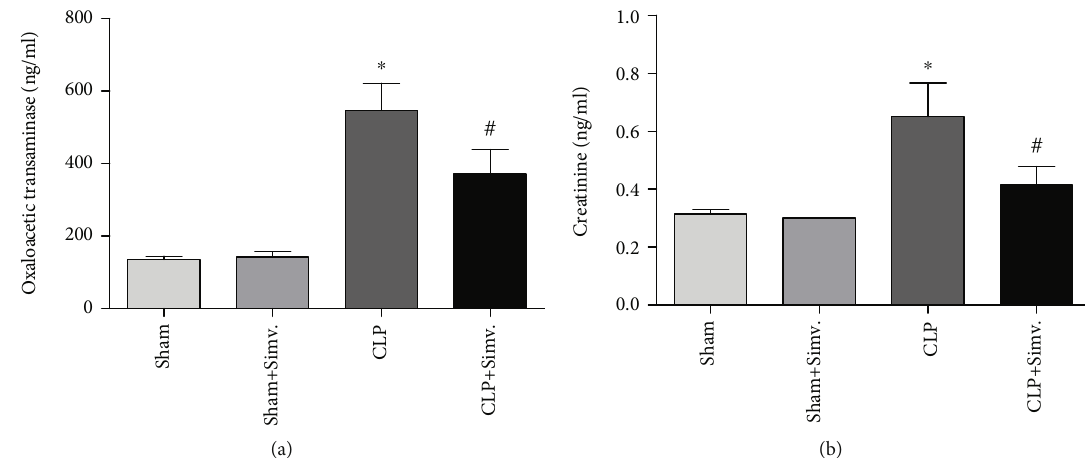
Figure 1: Simvastatin e ff ect on hepatic (a) and renal (b) function in the animals submitted to CLP. SW mice submitted to CLP, treated or untreated with simvastatin, had the blood collected through cardiac puncture 24 hours after surgery for biochemistry analysis. Data represented as mean ± SEM of at least 6 animals. ∗ p < 0 : 05 , control vs. CLP+vehicle; # p < 0 : 05 , CLP+vehicle vs. CLP+ simvastatin.